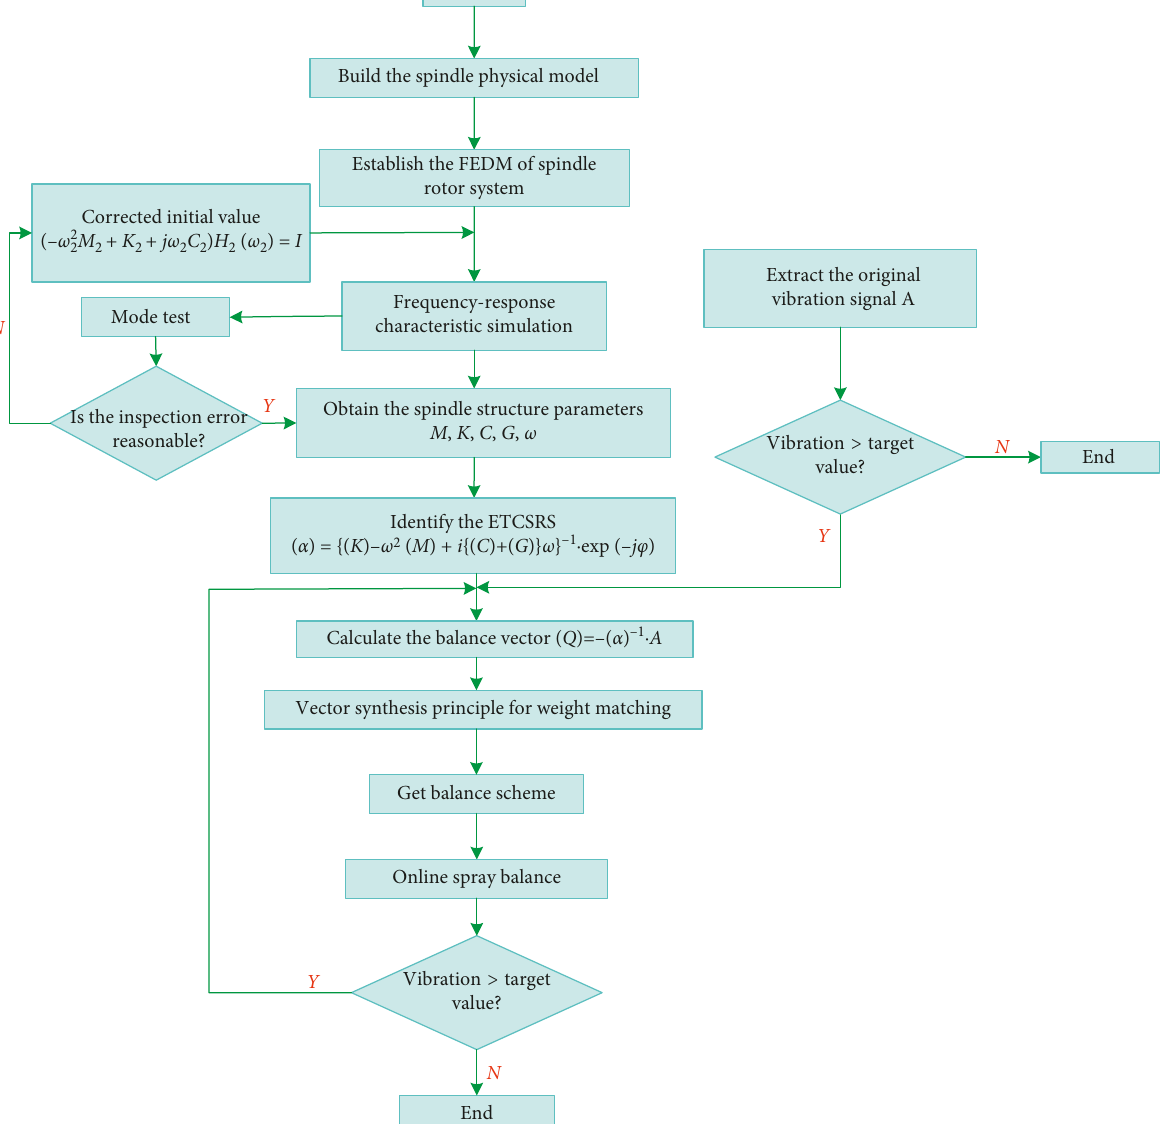
cavity angle and the unbalance vector unbalance vector.